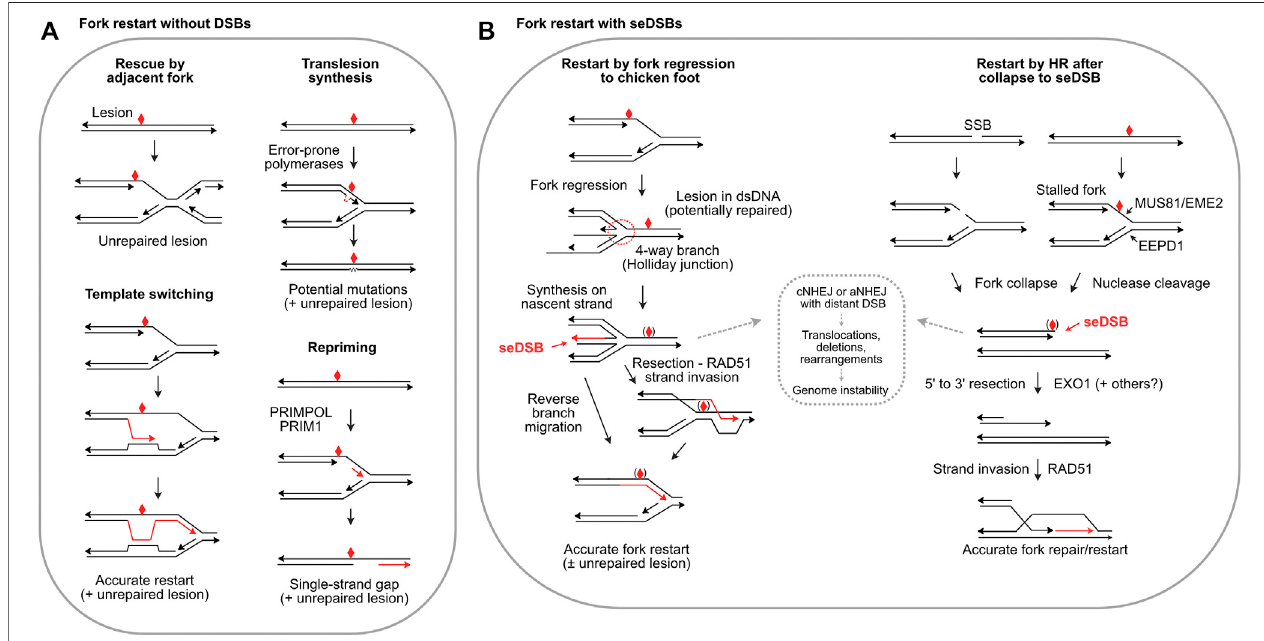
FIGURE2 | Fork restart mechanisms. (A) Fork restart mechanisms that do not create seDSBs. Illustrated are rescue by anadjacentfork, TLS, template switching, and repriming. Blocking lesions are shown by red symbols and repair or bypass synthesis is shown by red arrows. (B) Fork restart by fork regression, fork encounters withasingle-strandbreak(SSB),orforkcleavage,whichcreateseDSBs.Regressedforks allowsynthesispasttheblockinglesion usingthenascentstrand astemplate. Reverse branch migration restarts the fork, or RAD51 may load onto a resected end allowing strand invasion downstream of the blocking lesion. Blocking lesions may be bypassed or repaired, indicated by symbolsin parentheses. Collapsed forks due to encounter with single-strand breaks or fork cleavage can restart by RAD51- mediated strand invasion, i.e., break-induced replication. The strand invasion restart pathways are mediated by HR; fork regression/reversal is not an HR pathway,